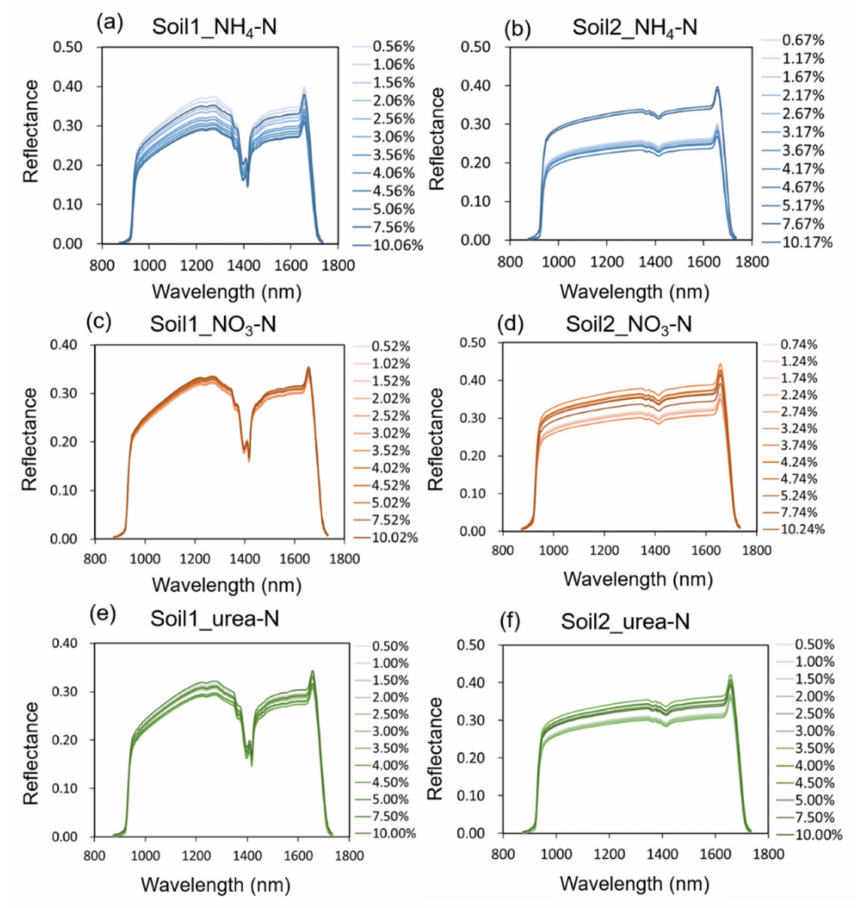
Figure 2. Average NIR reflectance spectra of the six sample sets: ( a ) Soil1_NH 4 -N; ( b ) Soil2_NH 4 -N; ( c ) Soil1_NO 3 -N; ( d ) Soil2_NO 3 -N; ( e ) Soil1_urea-N; ( f )